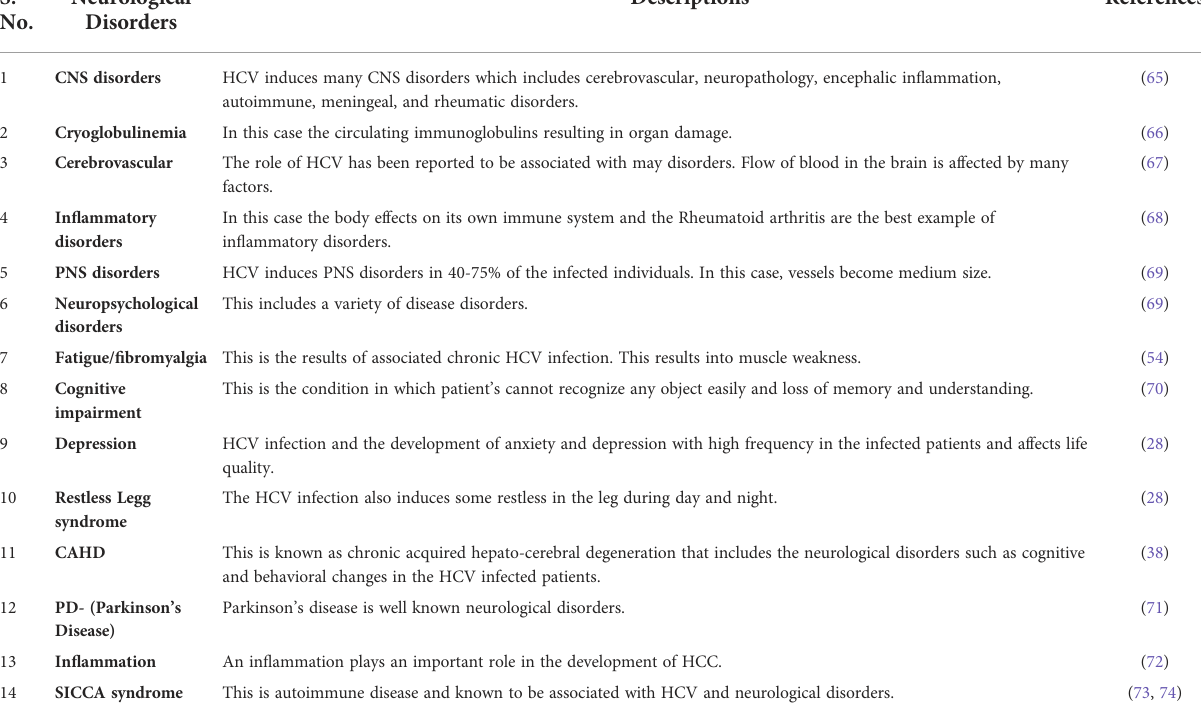
TABLE 2 Role of HCV in the development of neurological disorders. S.